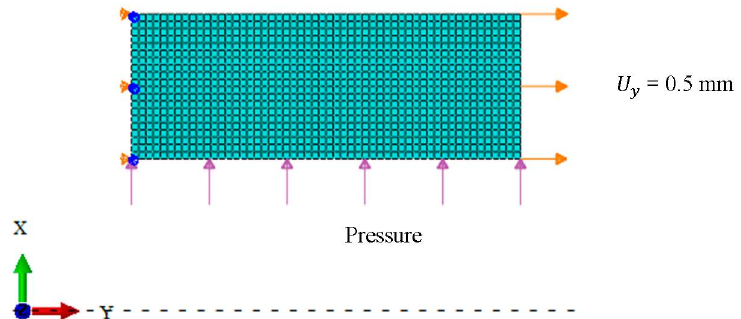
Figure 5. Finite element model of dissimilar metal welded joints.